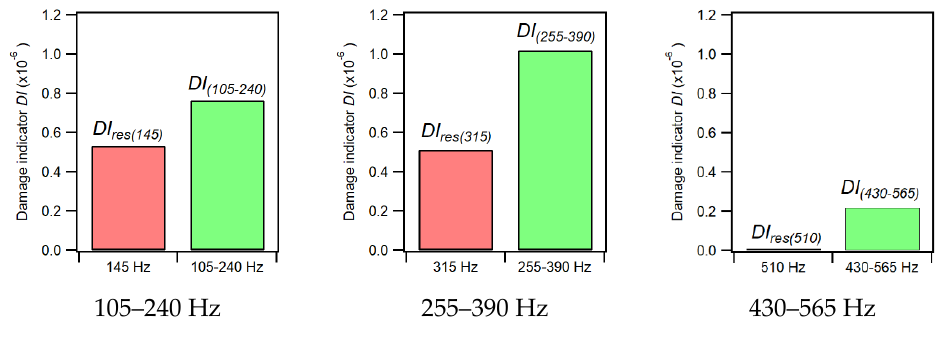
evaluated at a resonance frequency (red 𝐷𝐷𝑀𝑀